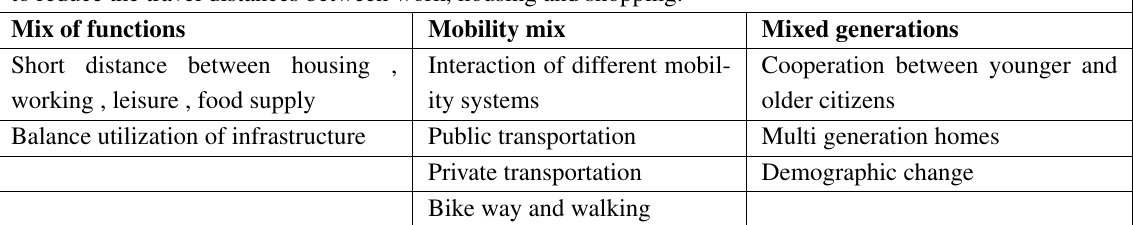
Table 8. Science city - Identity and characteristics